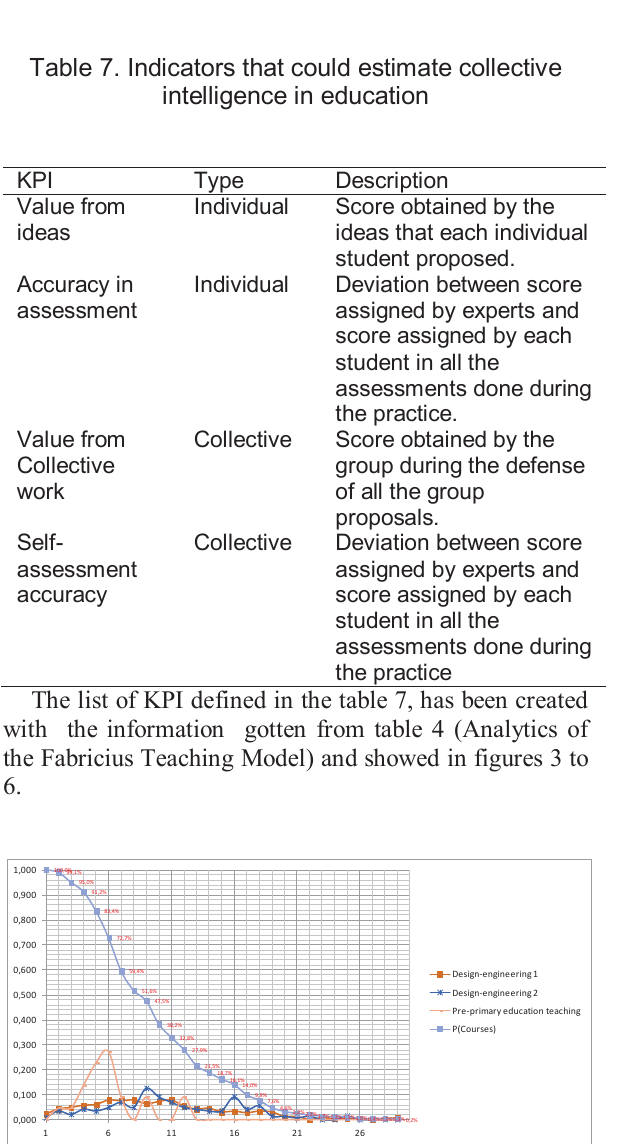
Figure 3 . Individual performance Figure 3 is related with the contributions, a contribution is considered completeness when it has proposed and voted , hence , it's shown the number of votes by ideas